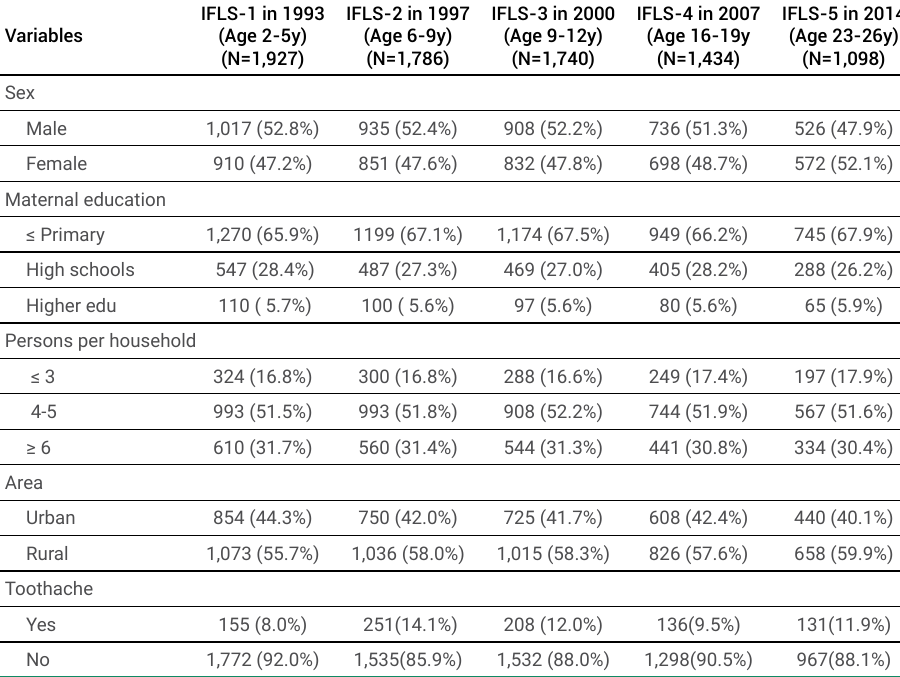
Table 1. Distribution of sociodemographic characteristics and toothache experience among participants in every cohort (IFLS1-5)